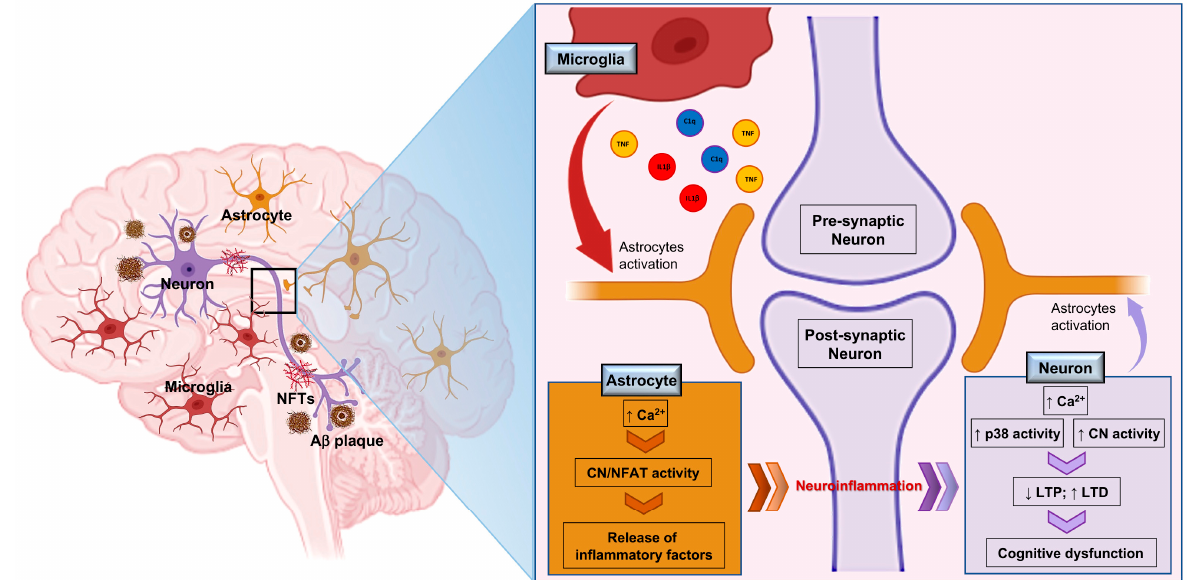
Figure 1. Crosstalk between Ca 2+ dysregulation and neuroinflammation in Alzheimer’s disease. Among many other possible causes, the accumulation of amyloid- β (A β ) plaques and neurofibrillary tangles (NFTs) in the AD brain, besides inducing microglia activation, bring about Ca 2+ dysregulation in astrocytes. Ca 2+ dysregulation increase calcineurin (CN) activity in astrocytes with AD, where CN assumes control over gene regulation through the activation of nuclear factor of activated T cells (NFAT) transcription factors, leading to the production and release of several inflammatory media ‐ tors, such as cytokines. In turn, inflammatory factors induce Ca 2+ dysregulation and activation of the MAP kinase signalling pathways (p38) in neurons, leading to increased CN activity. Hyperacti ‐ vation of CN in neurons determines transcriptional repression of several genes, especially those related to synapse function and integrity, causing synaptic plasticity deficits, neurite degeneration, and cognitive impairment. These parameters further participate in the activation of nearby astro ‐ cytes leading to the dysregulation of astrocytic Ca 2+ and hyperactivity of astrocytic CN that, through the regulation of the transcriptional induction of genes, sustain glial activation and neuroinflamma ‐ tion, negatively affecting neurons and exacerbating neuronal Ca 2+ dysregulation. Perpetuation of this vicious cycle drives the progression of AD pathology. 2. Neuroinflammatory Scenario in Alzheimer’s Disease: The Role of Microglia and Astrocytes 2.1. Microglia and Astrocytes: The Main Actors of the Neuroinflammatory Response Over the years, several hypotheses have been proposed to unveil the complex patho ‐ logical mechanisms underlying AD ‐ related neurodegeneration [23]. However, the ulti ‐ mate aetiology of AD remains obscure. The discovery of elevated levels of inflammatory markers associated with cognitive decline in AD patients and the identification of AD risk genes associated with innate im ‐ mune functions suggest that neuroinflammation holds a crucial role in AD pathogenesis [24]. Neuroinflammation not only occurs in an early phase of the disease, but may also drive its progression [25]. The main immune cell components of the central nervous system (CNS) microglia and astrocytes, represent the cellular master regulators of inflammatory responses in the brain [10], and as resident innate immune cells, are strongly implicated in aberrant mo ‐ lecular pathways that underlie AD pathogenetic alterations [26]. Traditionally, both types of cells can assume multiple reactive phenotypes, neurotoxic and neuroprotective, which are related to the stage of the disease and to the regional location [10].